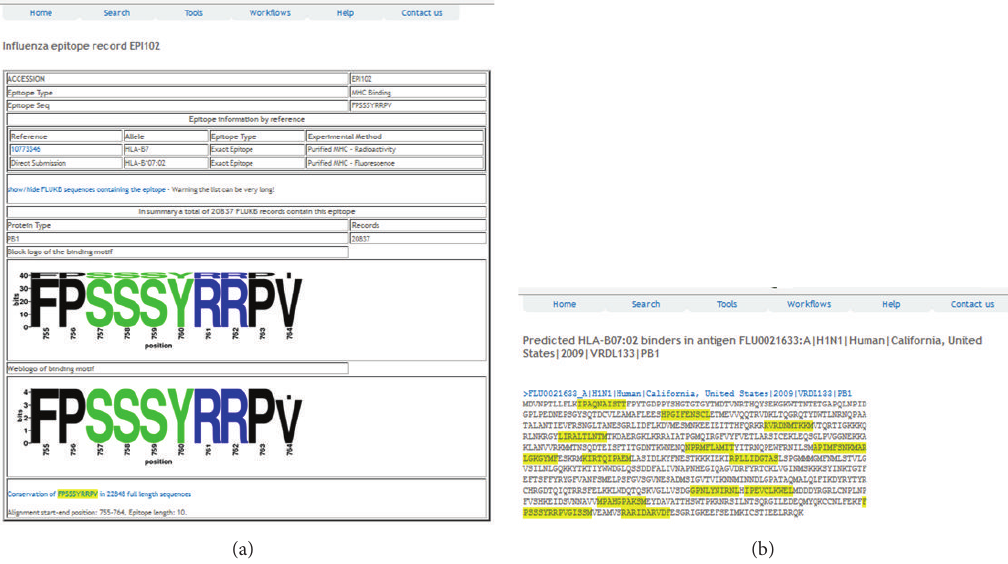
Figure 4: T-cell epitope EPI102 and the T-cell epitope analysis from the record FLU0021633. (a) Entry EPI150 with the graphical display of present T-cell epitope variants. (b) Graphical display of predicted T-cell epitopes (HLA-B ∗ 07:02, length 10, IC 50 <